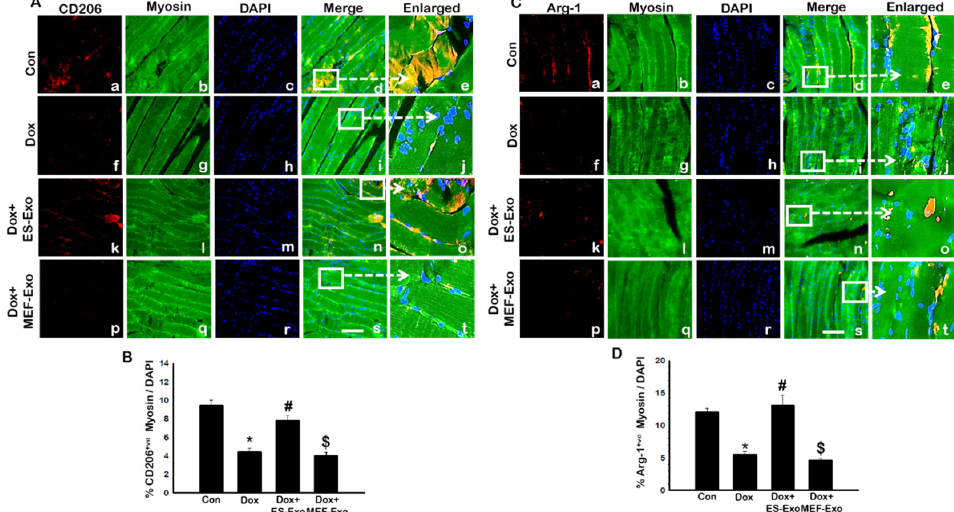
Figure 11. ES-Exos enhances levels of anti-inflammatory M2 macrophage markers, CD206 and Arg-1 in Dox mice. ( A ) Representative photomicrographs of soleus muscle sections stained with myosin and M2 macrophage marker, CD206. Each box shows CD206 + cells in red ( a , f , k , p ), myocytes in green ( b , g , l , q ), DAPI in blue ( c , h , m , r ), merged images ( d , i , n , s ), and enlarged areas of merged images ( e , j , o , t ). ( B ) Histograms from quantitative analysis of CD206 + cells over total DAPI. ( C ) Representative photomicrographs of soleus muscle sections stained with myosin and M2 macrophage marker, Arg-1. Each box shows Arg-1 + cells in red ( a , f , k , p ), myocytes in green ( b , g , l , q ), DAPI in blue ( c , h , m , r ), merged images ( d , i , n , s ), and enlarged areas of merged images ( e , j , o , t ). ( D ) Histograms from quantitative analysis of Arg-1 + cells over total DAPI. Error bars = mean ± S.E.M. * p < 0.05 vs. control, # p < 0.05 vs. Dox, $ p = non-significant vs. Dox, one-way ANOVA followed by Tukey test; Scale bar = 100 µ m, n = 14–16, male and female. Images taken at 40 ×